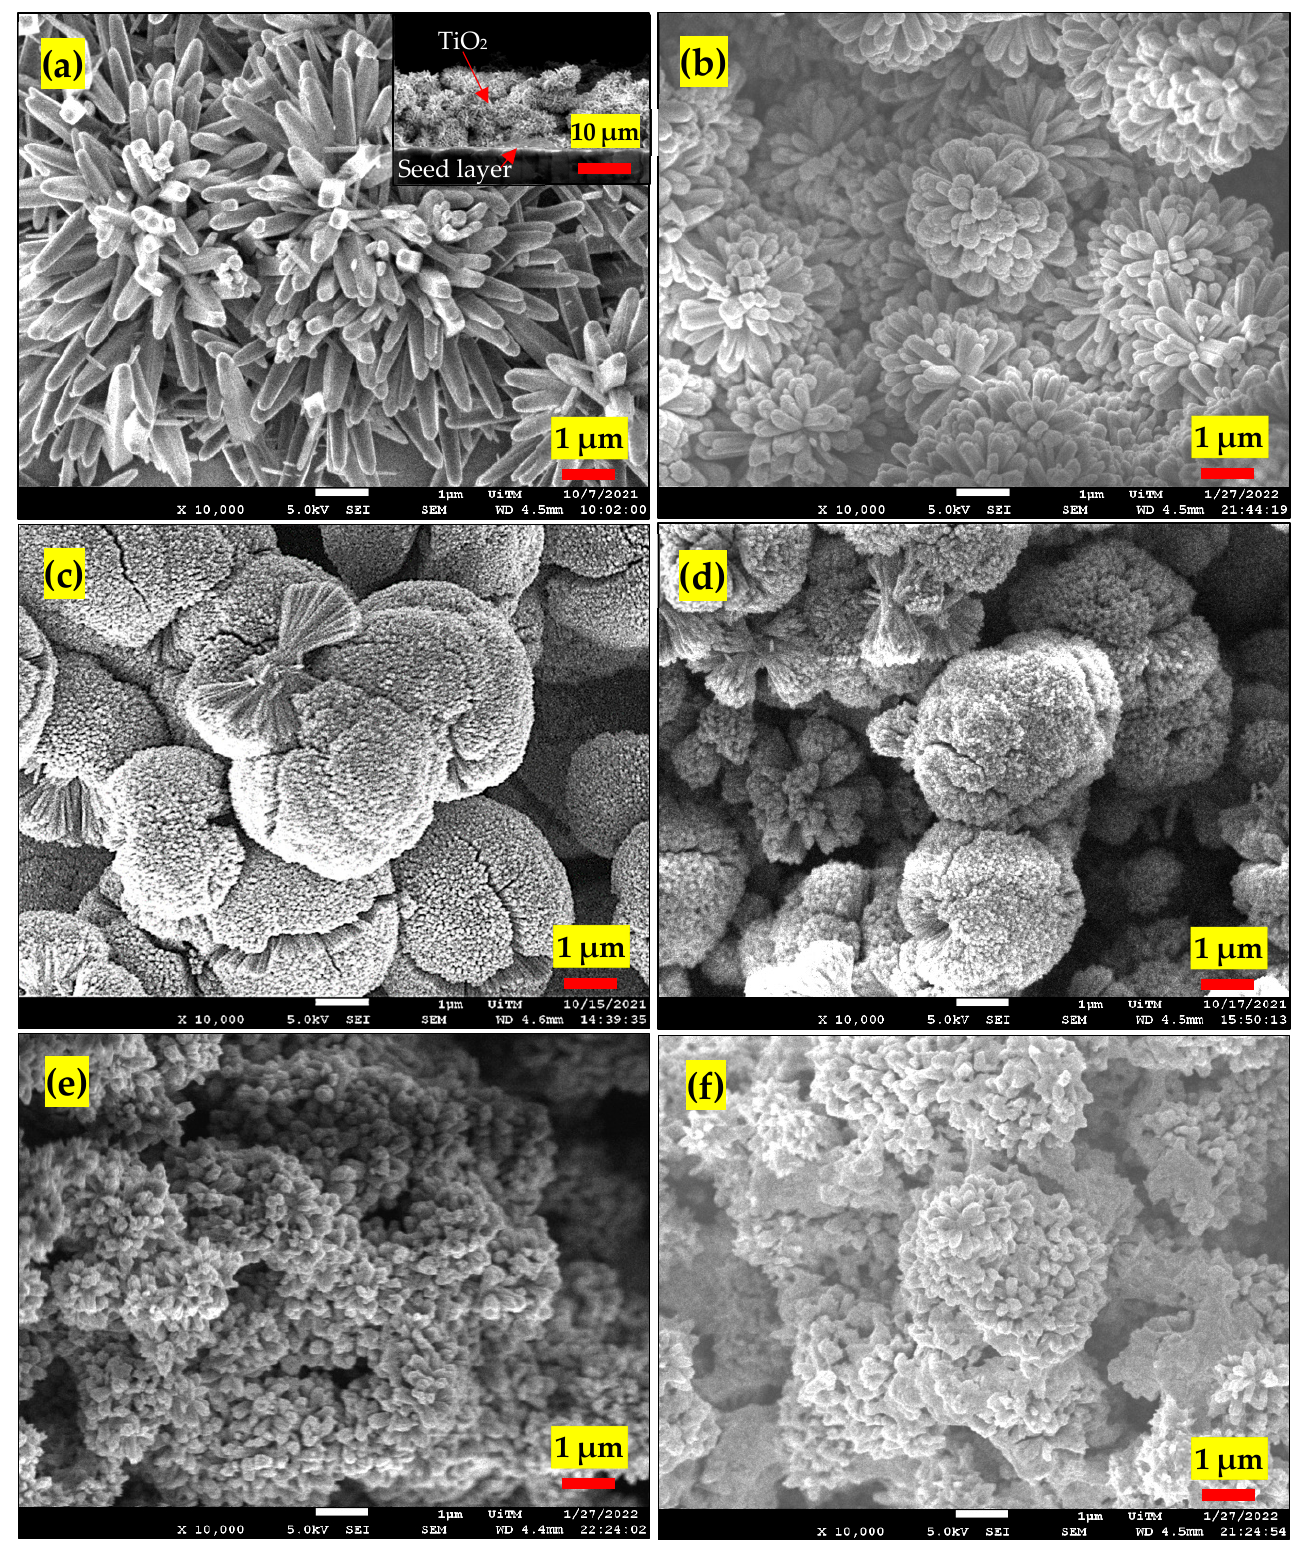
Figure 1. FESEM images of ( a ) UTD, inset cross-sectional view, ( b ) TAFM-1, ( c ) TAFM-3, ( d ) TAFM-5, ( e ) TAFM-7, and ( f ) TAFM-9 at 10,000 × magnification.